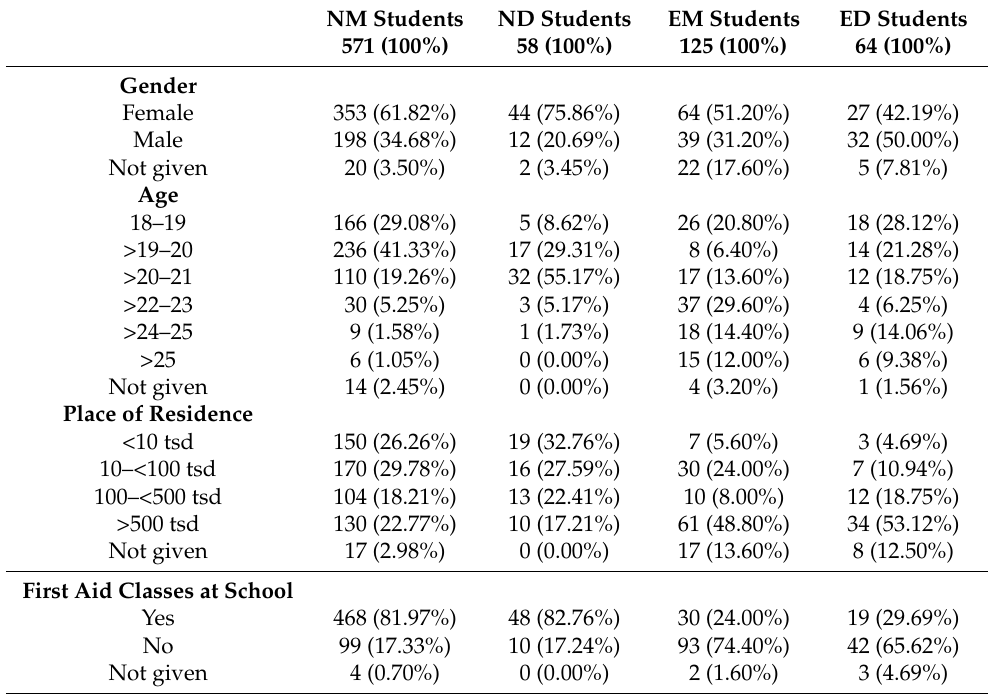
Table 1. Demographic data and information about first aid classes at school.